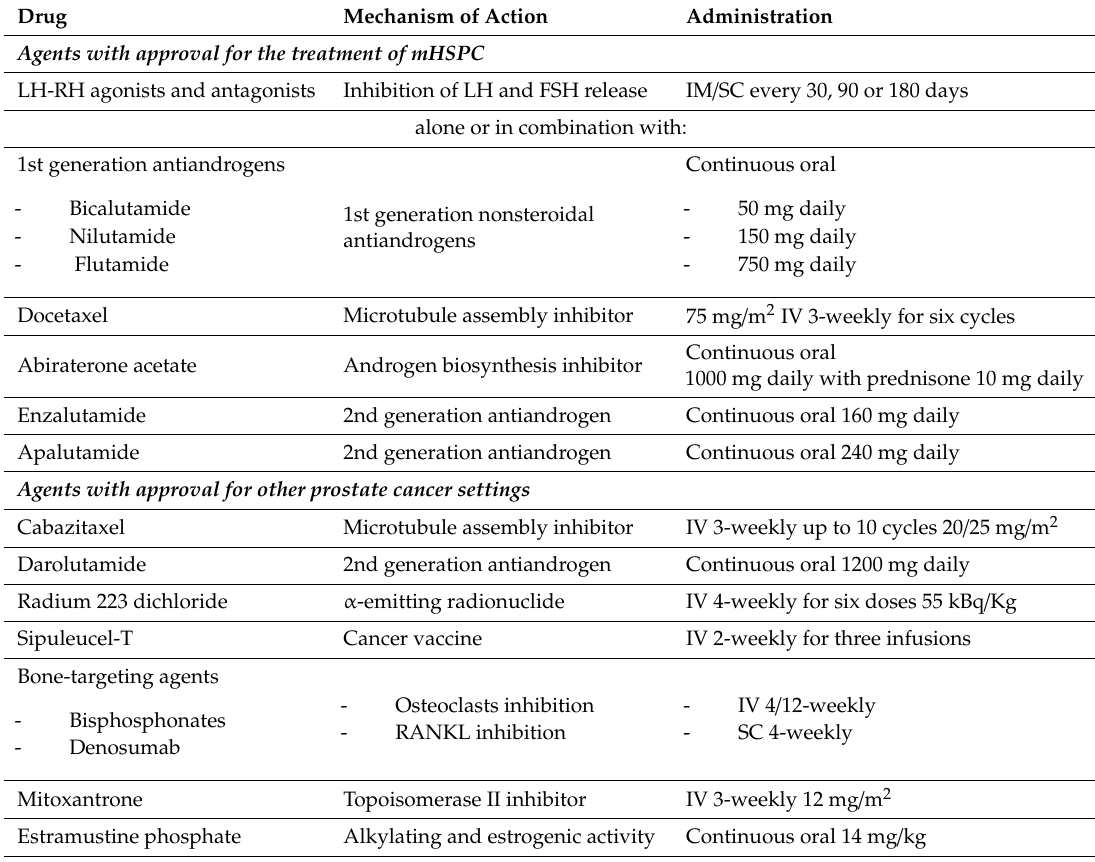
Table 2. Systemic agents that are currently approved for the treatment of prostate